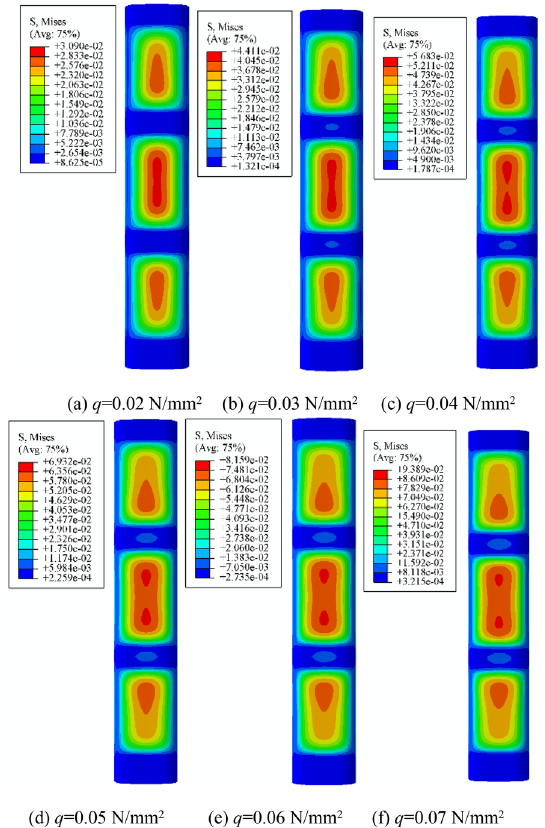
Figure 13 Graph of maximum contact stress with uniformly distributed load